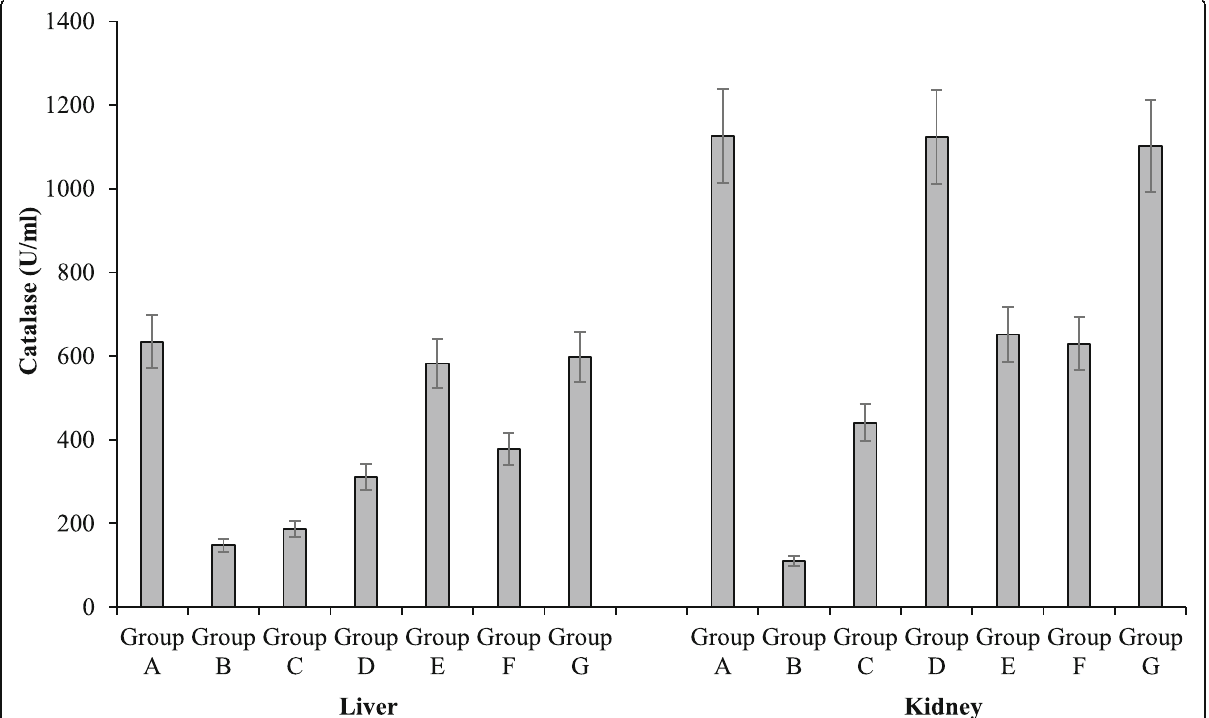
Fig. 3 Effects of aqueous extract of fruit pulp of A. digitata on the mean Catalase antioxidative activities and oxidative stress in the organs of albino rats in the different